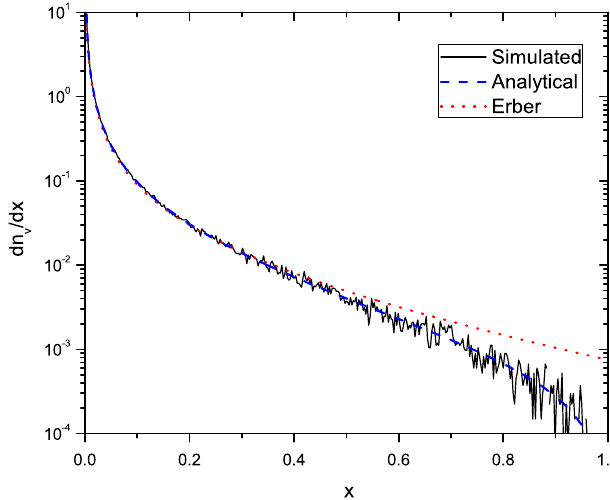
FIG. 7. Spectrum of virtual photons used for generating direct tridents, x ¼ ℏ ω =E 0 . The expression (11) ( “ analytical ” ) exhibits a cutoff in the maximum energy, which is clearly more physical than the semiclassical spectrum ( “ Erber ” ) from